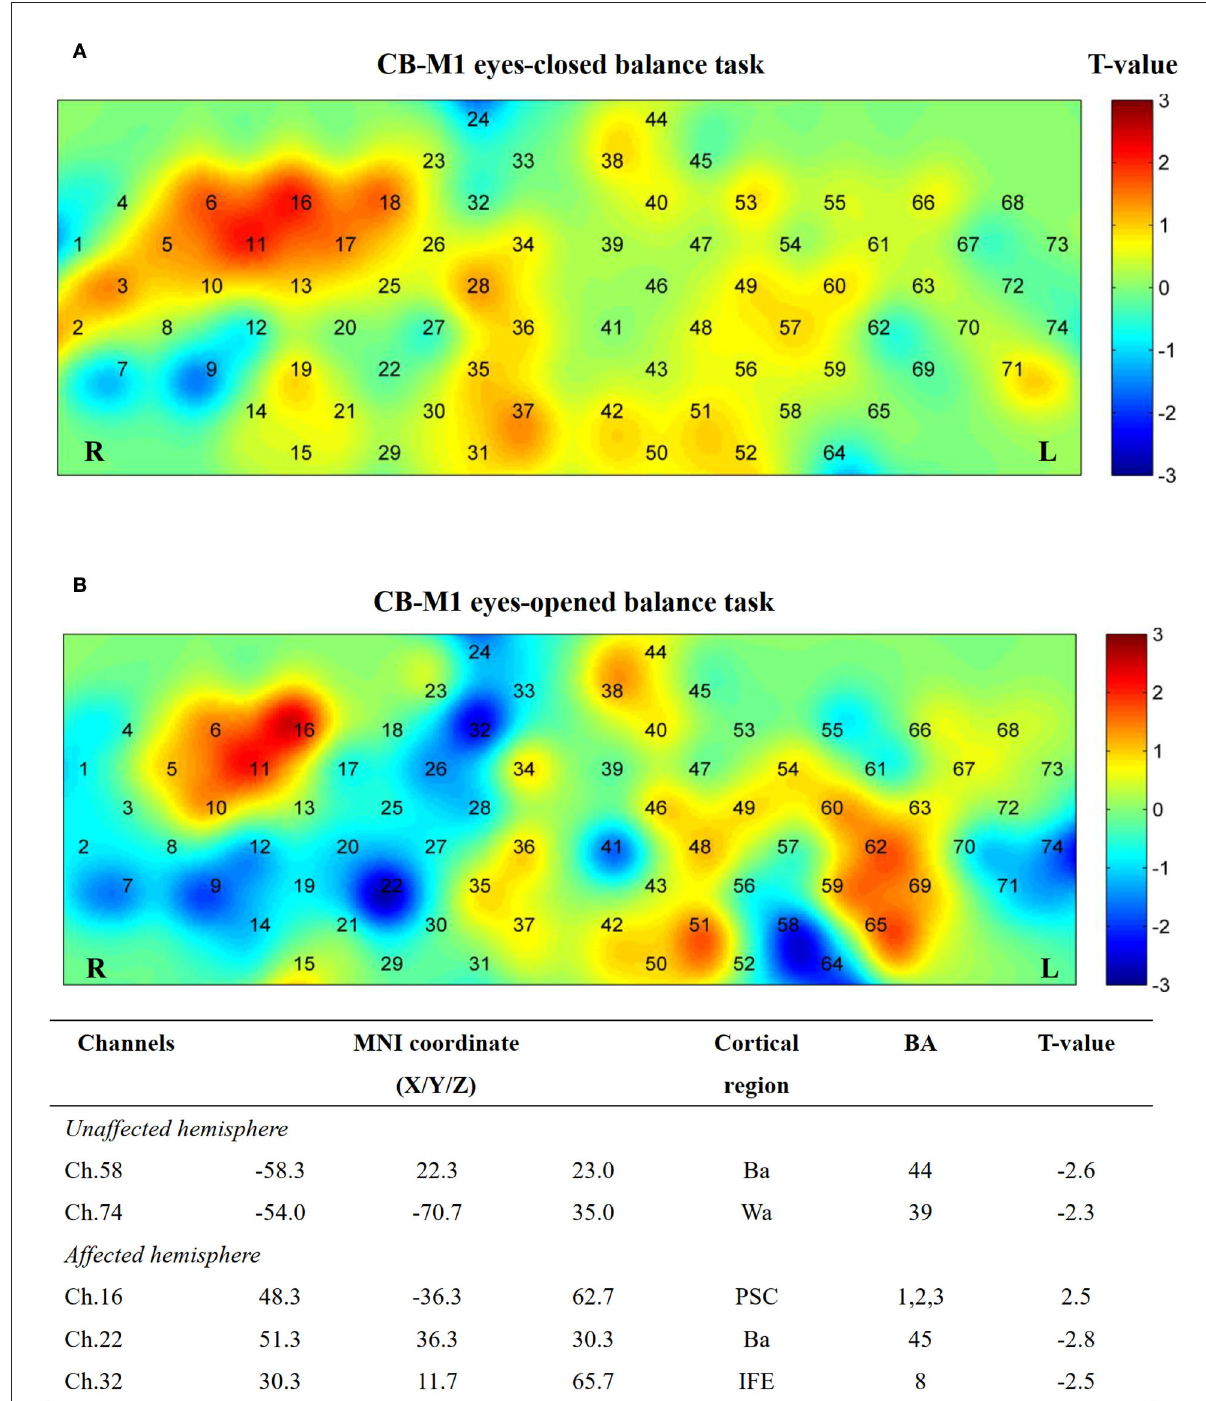
FIGURE8 Cortical activation map in CB-M1 group in EC condition (A) and EO condition (B) . Results from paired t -test of beta value between post- and pre-CB-M1 iTBS protocol. None channels passed FDR correction. Channels with a meaningful trend have been listed.